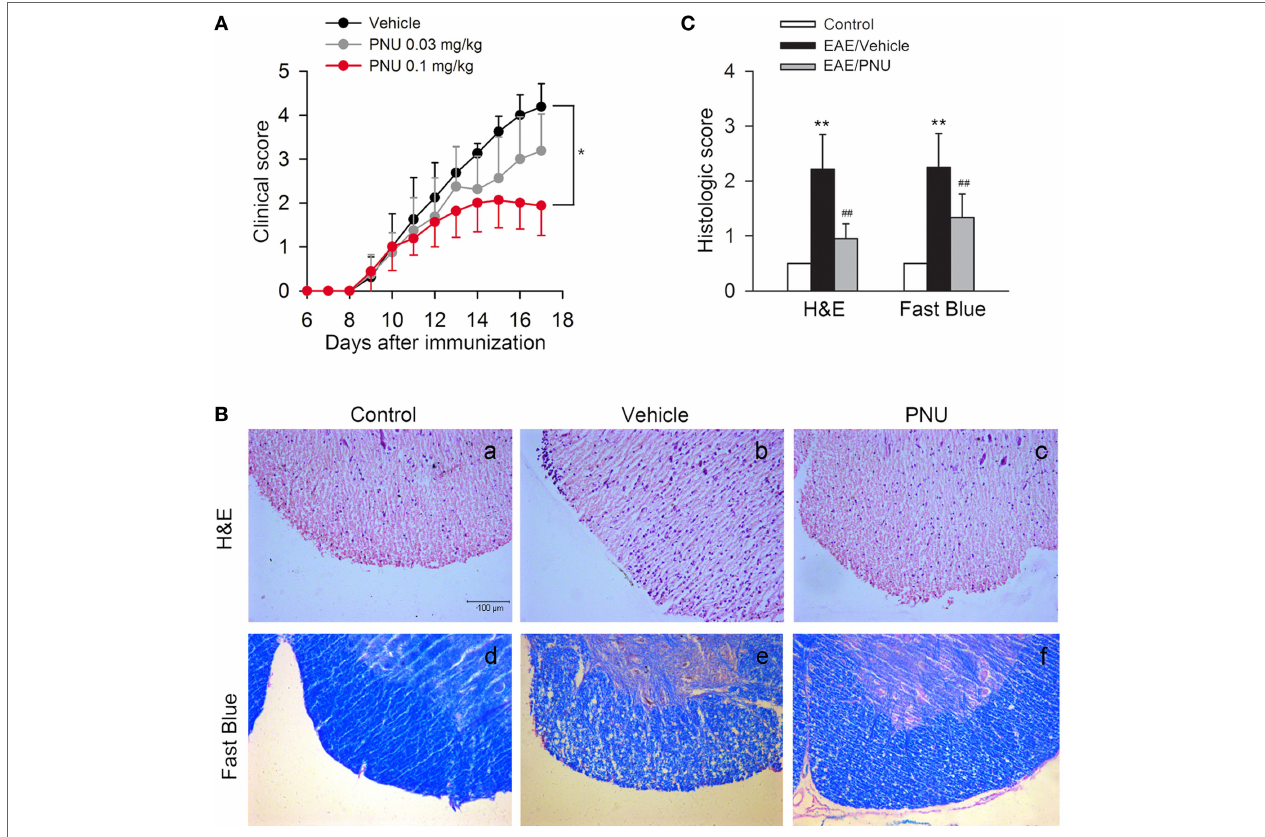
FigUre 1 | α 7nachr activation alleviates experimental autoimmune encephalomyelitis (eae) severity and central nervous system inflammatory infiltration in eae mice . EAE mouse model was created and treated with PNU282987 (0.03 and 0.1 mg/kg, i.p.) or vehicle from day 3 postimmunization and were maintained on drug for the duration of the study. (a) Clinical signs were assessed daily. 0.1 mg/kg PNU282987 effectively reduced the peak severity and cumulative clinical score of EAE mice while only slight decreases in the peak severity and cumulative clinical score were detected at the dose of 0.03 mg/kg body weight ( n = 8 per group). * P < 0.05 vs vehicle. (B,c) H&E and luxol fast blue staining of paraffin sections of spinal cords isolated from control, vehicle, or PNU282987 (0.1 mg/kg)- treated EAE mice on day 17 ( n = 8 per group). PNU282987 ameliorated spinal inflammatory infiltration and demyelination compared with vehicle. Scale bar, 100 µm. ** P < 0.01 vs control; ## P < 0.01 vs vehicle. Veh, vehicle; PNU,